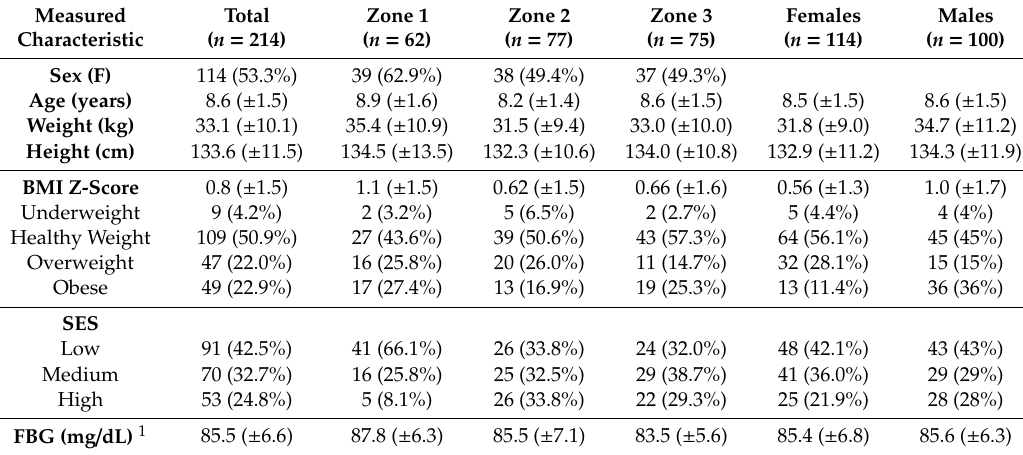
Table 2. Sociodemographic and physical characteristics of the study cohort (mean ( ± SD) or n (%)) in totality, by residential zone, and by sex (BMI = Body mass index; SES = socio-economic status; FBG = fasting blood